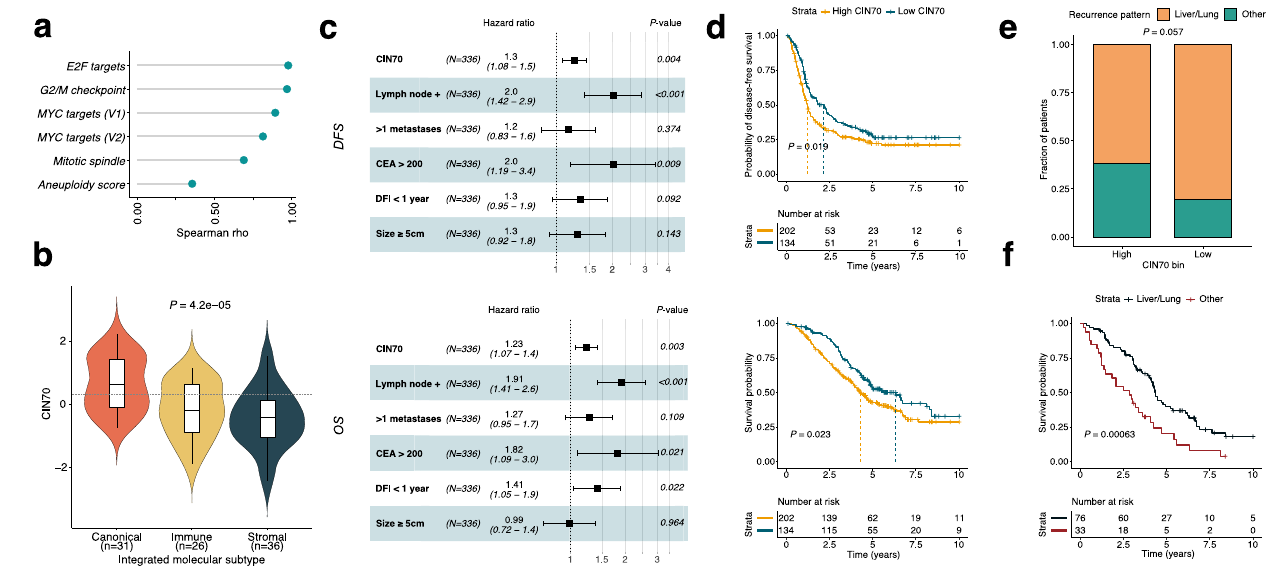
Fig. 1 Prognostic value of CIN70 in CRCLM. a Spearman correlation of CIN70 score with Hallmark proliferation signatures and aneuploidy score; all correlations P < 0.05. b Comparison of CIN70 scores among CRCLM molecular subtypes; dashed line denotes median CIN70 score of all samples ( n = 93); boxplot top and bottom edges represent the 1st and 3rd quartiles, respectively; the center line represents the median; whiskers extend to the farthest data points which do not represent outliers (within 1.5x the interquartile range); outliers are plotted as points above and below the box-and-whisker plot; Kruskal – Wallis test. c Forest plots of multivariable Cox proportional hazards models for DFS (top) and OS (bottom) of the pooled datasets ( n = 336). Squares represent point estimates; bars represent 95% con fi dence intervals. Multivariable P - values and hazard ratios are displayed. CIN70 scores were evaluated as a continuous variable whereas other covariates with binary variables. CEA: carcinoembryonic antigen, DFI: disease-free interval between primary tumor and presentation of liver metastasis. d Kaplan – Meier curves of the pooled datasets ( n = 336) for disease-free (upper panel) and overall survival (lower panel); log-rank test. High CIN70 de fi ned as scores ≥ 40th percentile within each dataset; log-rank test; vertical dashed lines represent median survival time for each group. e Stacked bar plots showing the percentage of patients with liver/lung vs. other site metastatic recurrence following curative-intent treatment of CRCLM in the UCMC and MSKCC cohorts ( n = 109); Fisher ’ s exact test. High CIN70 de fi ned as scores ≥ 40th percentile within each dataset. f Kaplan – Meier curves showing overall survival for patients with metastatic recurrence to liver/lung vs. other sites; log-rank